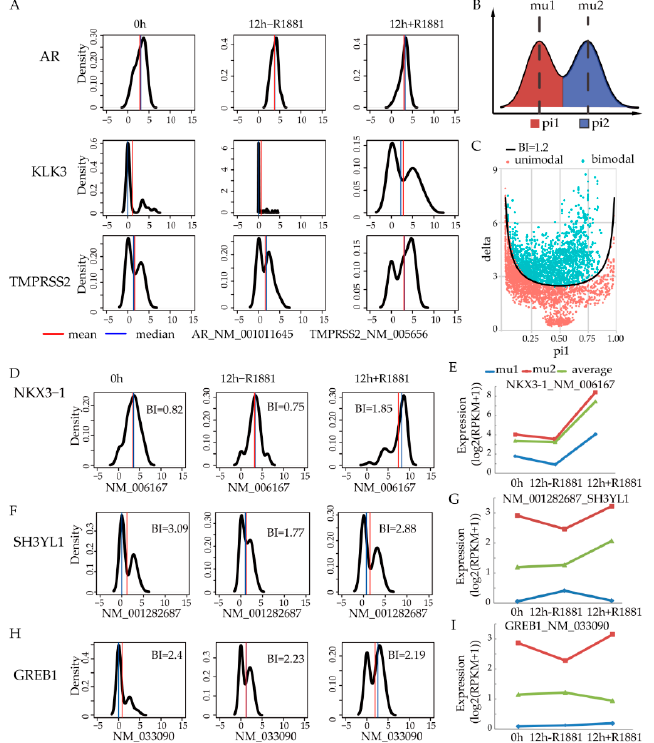
Figure 1. Bimodal gene expression among single cells reveals averaging pitfalls. ( A ) Expression of marker genes (AR, KLK3, and TMPRSS2) in single cells; ( B ) The bimodality index (BI) is used to characterize the possibility of two subgroups among the single cells. Pi1 and pi2 represent the ratio of the lower group and higher group, respectively. Mu1 and mu2 denote the average level of individual groups; ( C ) Genes with BI > 1.2 (blue dots) are regarded as bimodally expressed genes; ( D ) Expression of known androgen regulated genes and corresponding BI value under each condition for NKX3-1; ( E ) Subpopulation expression of NKX3-1; ( F ) Expression trend of SH3YL1; ( G ) Subpopulation expression of SH3YL1; ( H ) Expression trend of GREB1; ( I ) Subpopulation expression of GREB1. Line charts show the average expression level in all single-cell (green line), higher group (red line), and lower group (blue